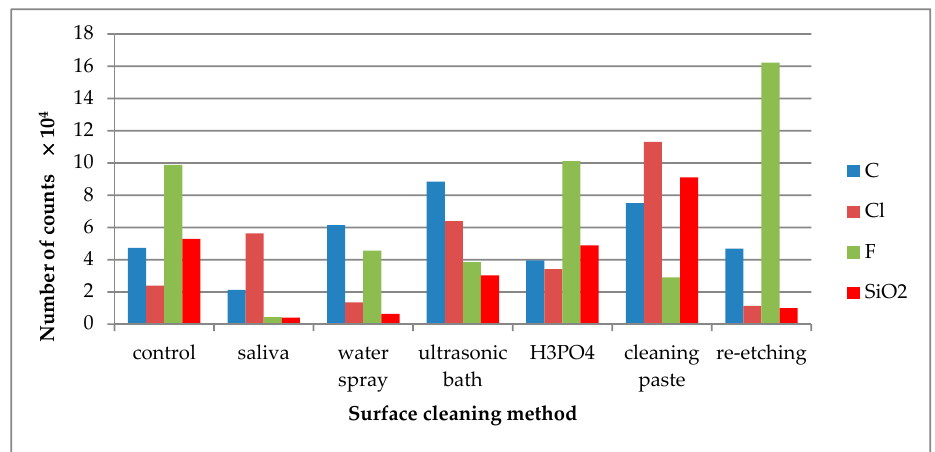
Figure 5. Number of counts of positive ions emitted from the surface of lithium disilicate glass ceramic (LDGC) after various surface cleaning methods.